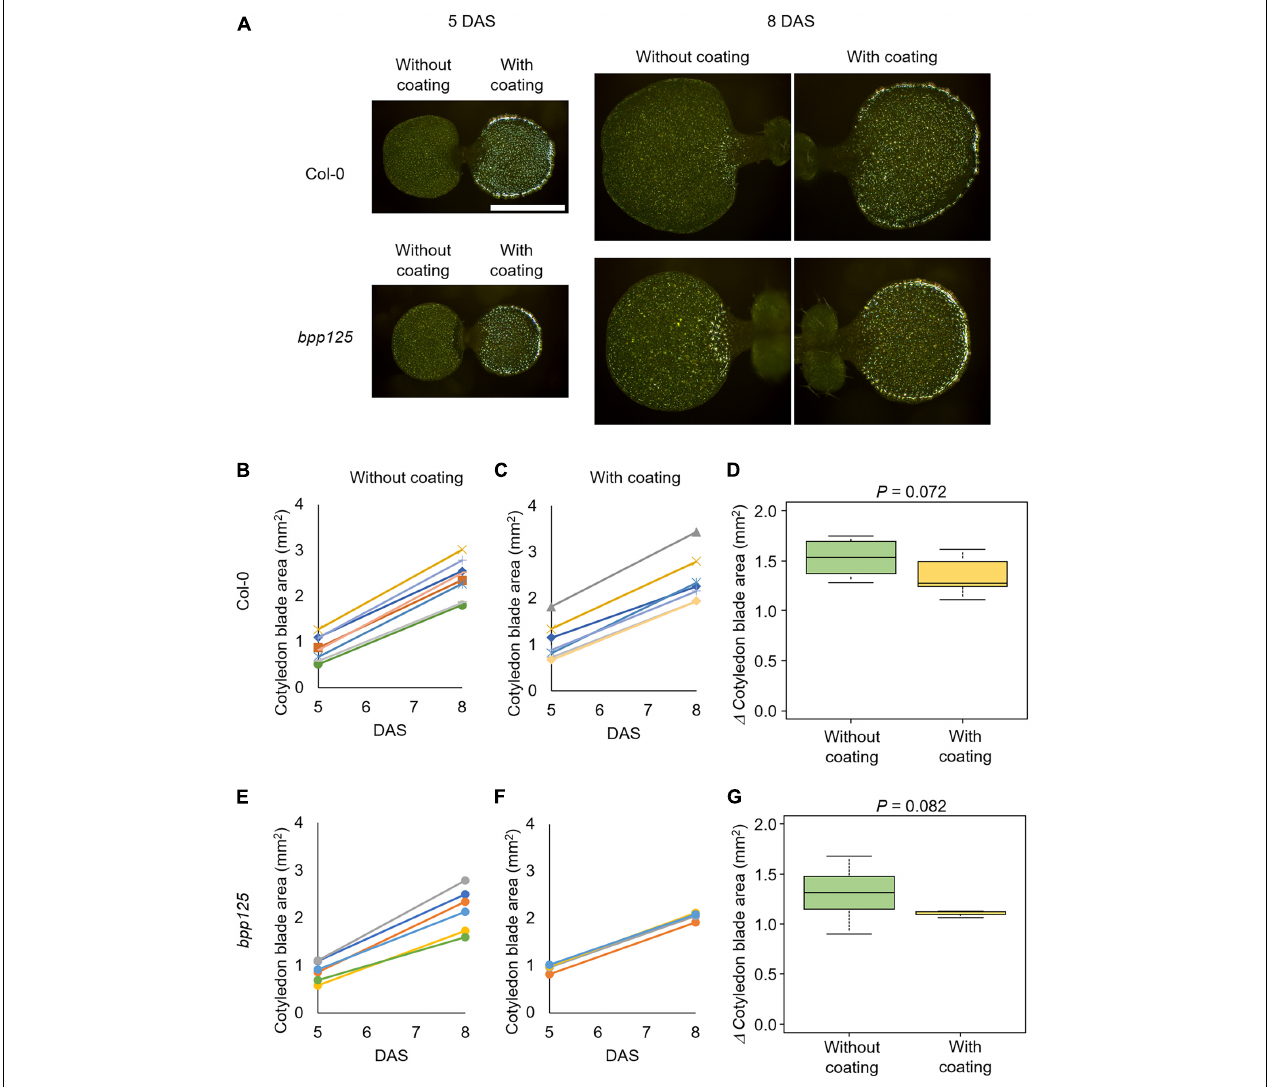
FIGURE 4 | Effects of silver ink coating on the expansion growth of cotyledons. (A) Growth of seedlings with only one side of one of the cotyledons coated with silver ink. Silver ink was applied to one cotyledon of wild type (Col-0) (top) and bpp125 triple mutant (bottom) seedlings. Growth was measured just after coating [5 days after sowing (DAS)] and again 3 days later (8 DAS). Both the silver ink-coated and uncoated cotyledons showed expanded growth. Scale bar indicates 1 mm. (B–G) Measurements of cotyledon blade area. The areas of wild type (Col-0) (B,C) and bpp125 (E,F) cotyledons without (B,E) and with silver ink coating (C,F) were measured. The same marker in the graph indicates the same cotyledon, and thus the lines in (B–F) show the expanded growth of the same cotyledons. Changes in cotyledon blade area from 5 to 8 DAS in the wild type (Col-0) (D) and bpp125 (G) . P -values were determined by Mann-Whitney’s U -test ( N =